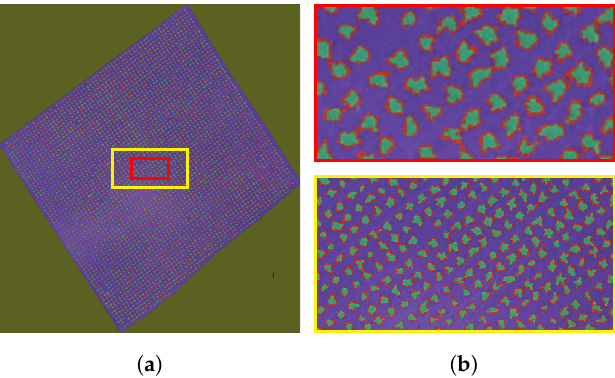
Figure 17. Semantic Segmentation results on the image of Parcel